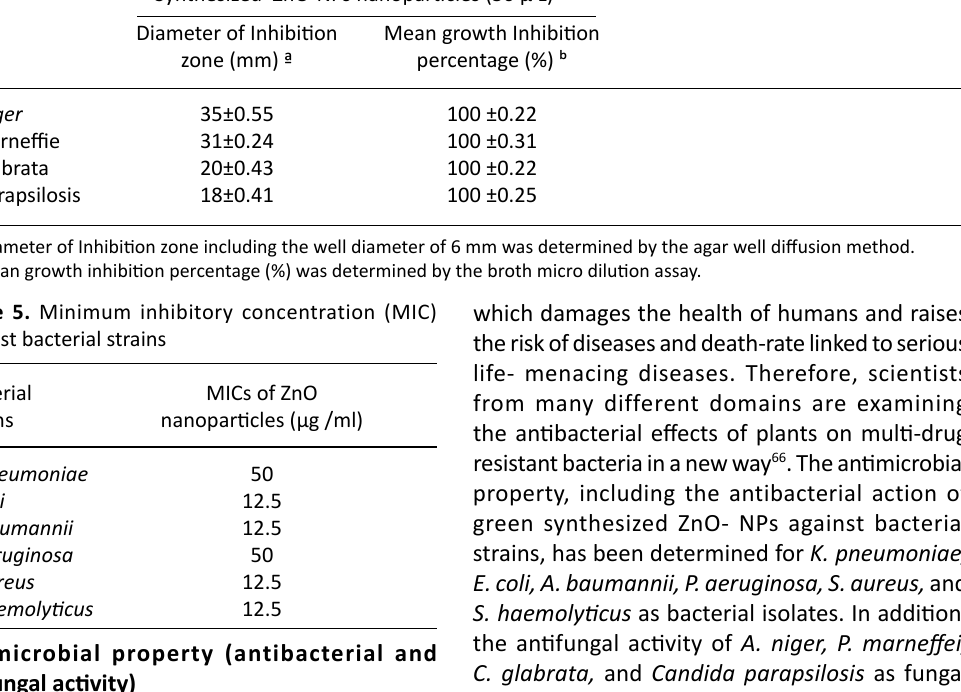
Table 4. The antifungal activity of prepared ZnO-NPs using agar well diffusion method and broth micro dilution assay Fungal Isolates